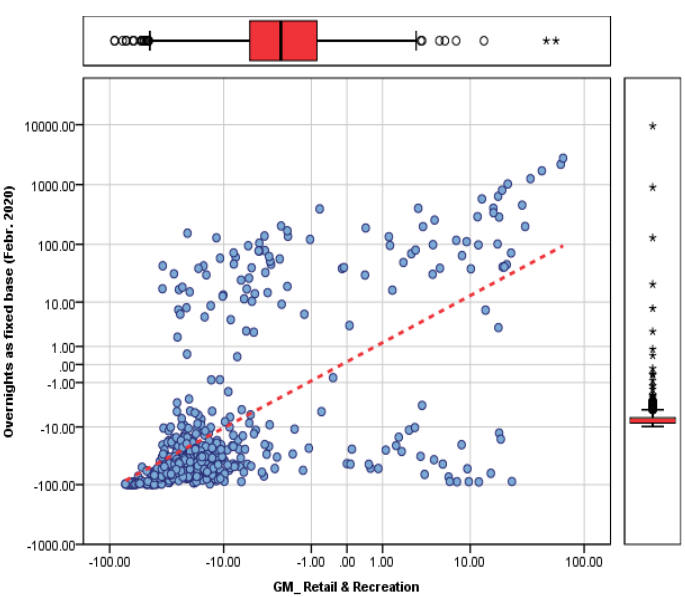
Figure 8. Overnight and GM Retail and Recreation.